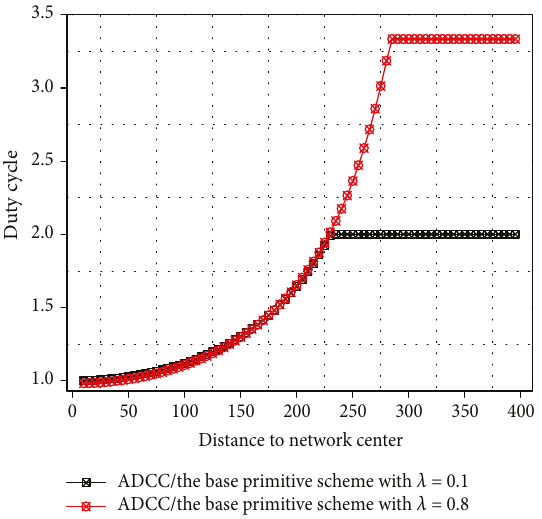
Figure 10: The ratio of duty cycle of nodes.